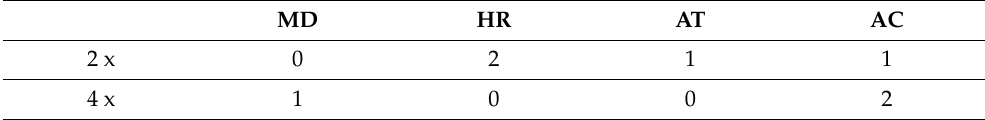
Table 1. Simplified representation of results (traditional vs. non-traditional). TN TB TC MD HR AT AC 2 x 0 0 3 0 0 0 0 4 x 0 0 3 0 0 0 0 Table 2. Simplified representation of results (non-traditional). MD HR AT AC 2 x 0 2 1 1 4 x 1 0 0